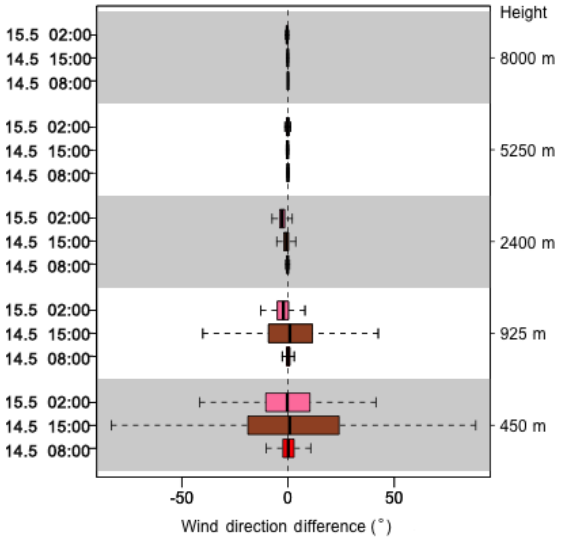
Figure 8. Wind direction differences between HR and DEFAULT in domain 3.